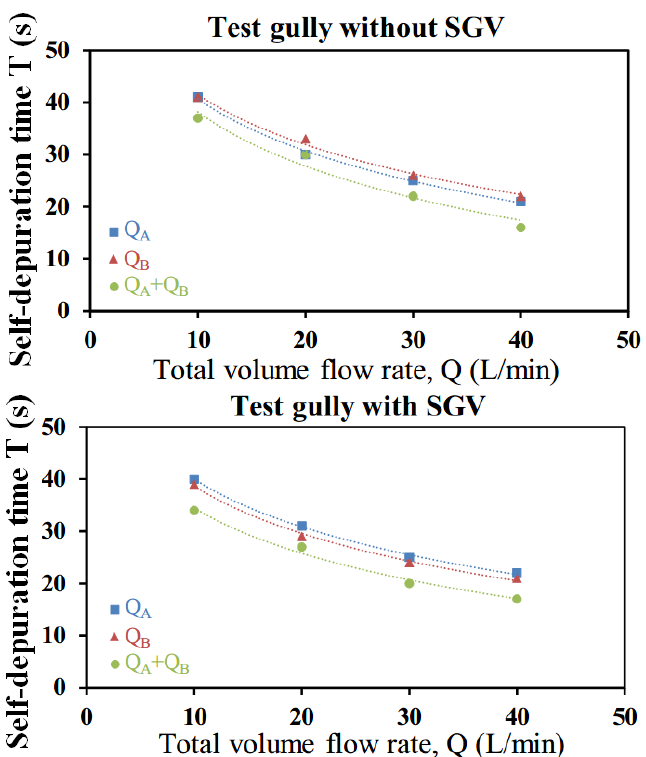
Figure 10. Variations of self-depuration time for test gullies without/with SGV at single/twin entry